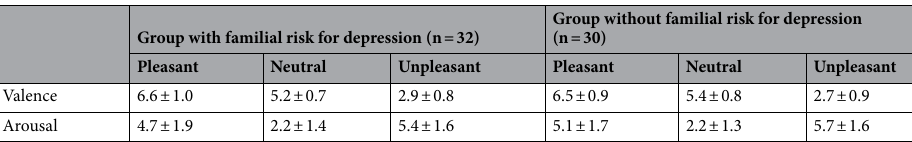
Table 1. Valence and arousal self-report ratings for pleasant, neutral, and unpleasant stimuli in the two groups. Data are mean ± standard deviation.